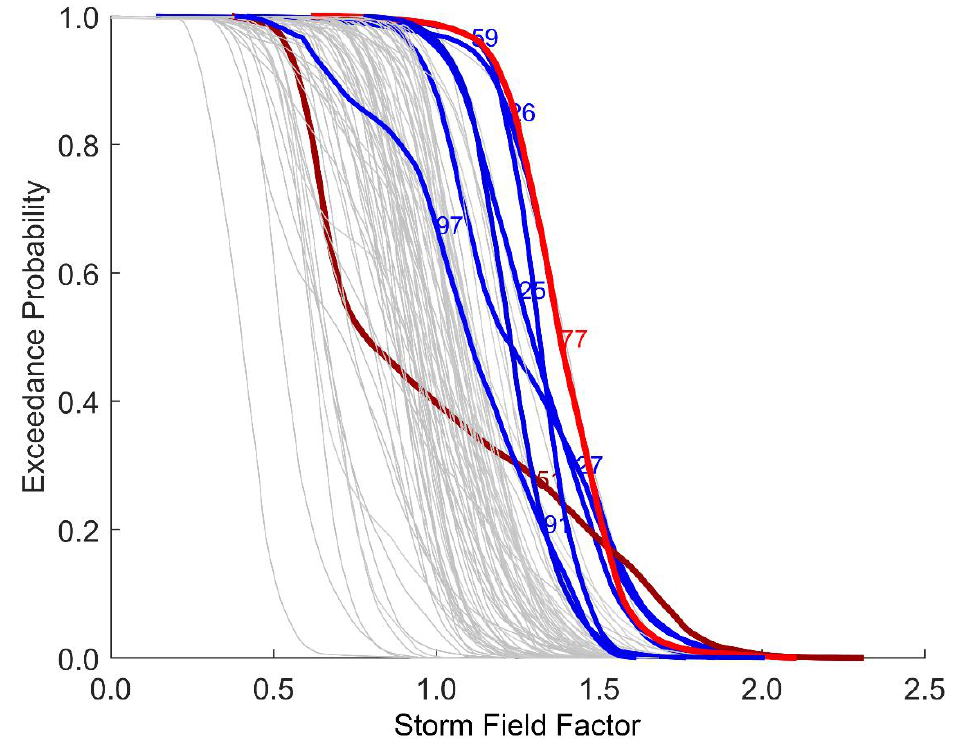
Figure 6. Survival functions (SF) of the winter storm-related storm field factor ( STF ) representing the share of study area. The eight most severe winter storms are labeled with their ID. The two winter storms (ID: 77, Kyrill; ID: 51: Lothar) which caused the greatest losses are colored red. The six next severe winter storms are colored blue. The grey lines indicate all other winter storms. 239